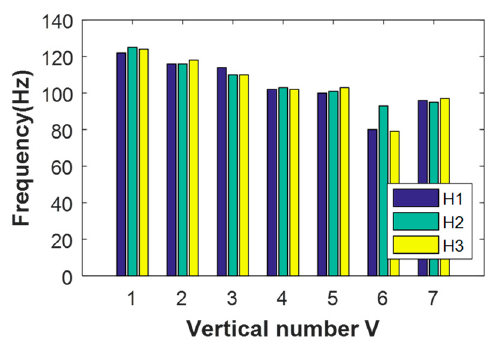
Figure 27. The first natural frequency with 2.1 kg of additional virtual mass after damage.